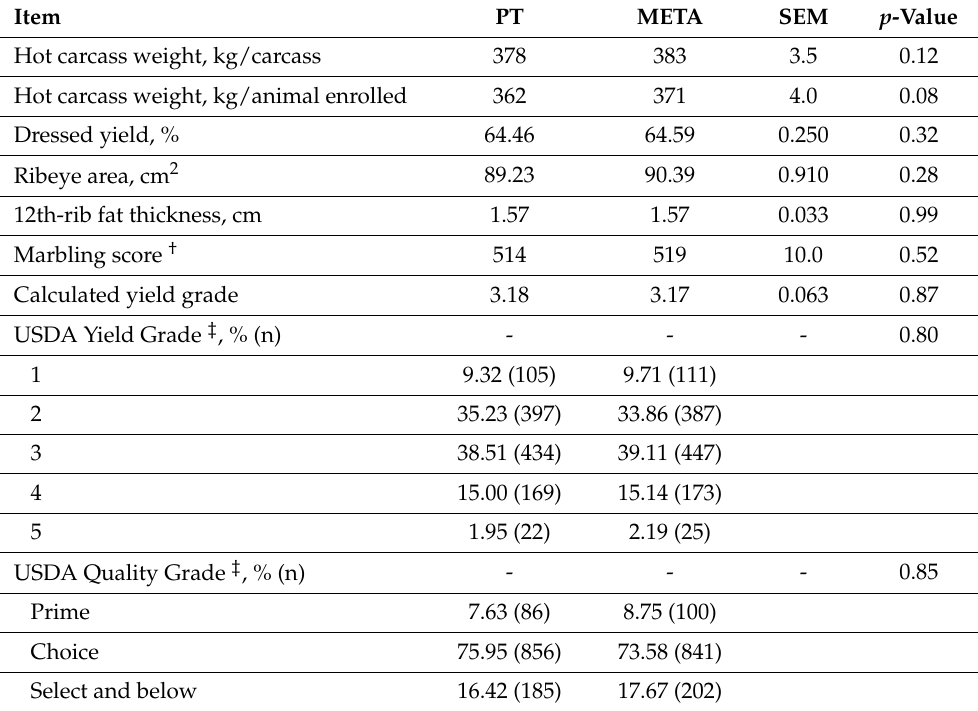
Table 4. Model adjusted means and standard errors of the mean (SEM) for carcass characteristics of steers and heifers at medium risk for bovine respiratory disease (BRD) that received metaphylaxis (META) or a pull-and-treat (PT) health program for BRD